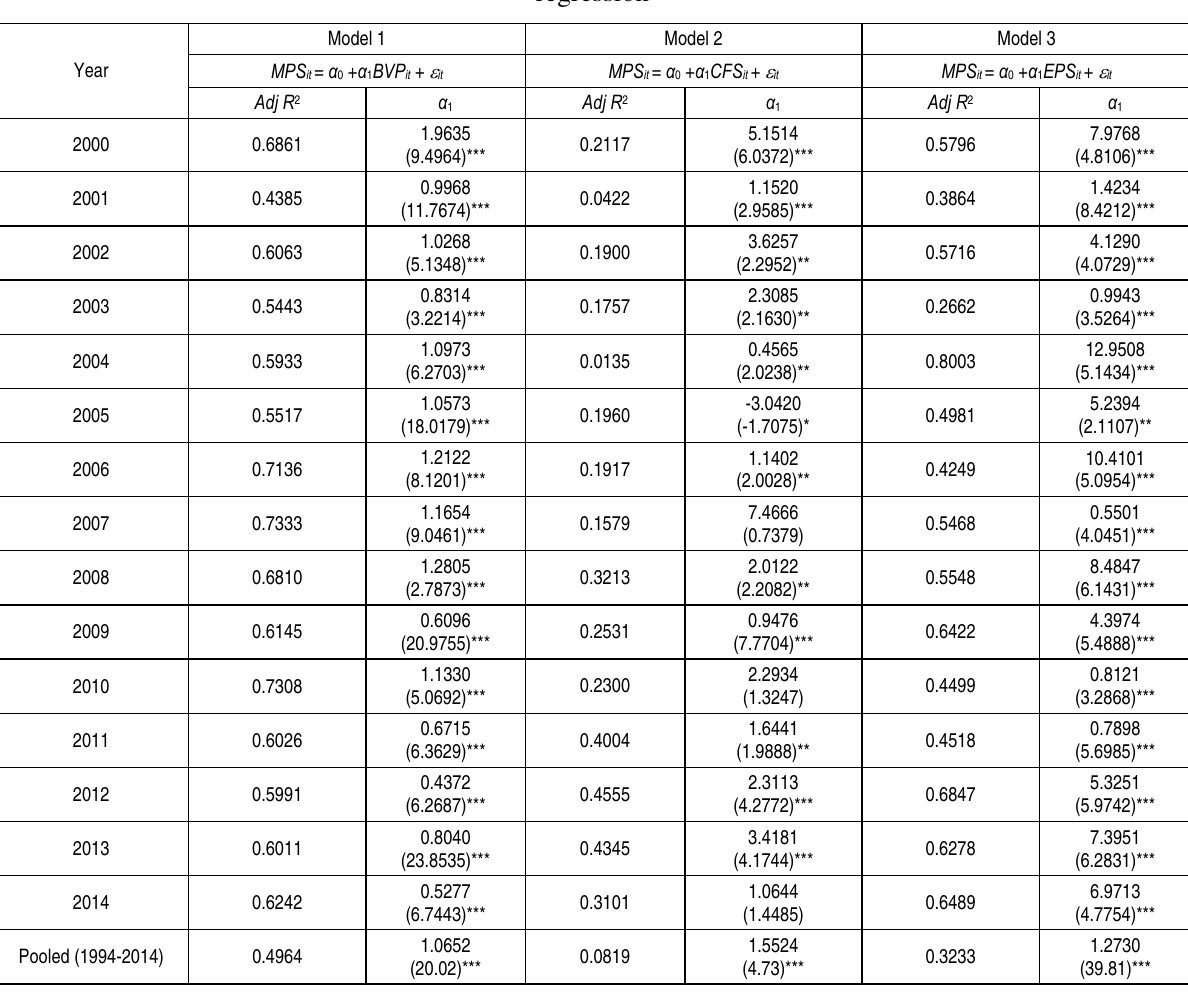
Table 4 (cont.). Analyses of the value relevance of book value, earnings and cash flows: simple linear regression